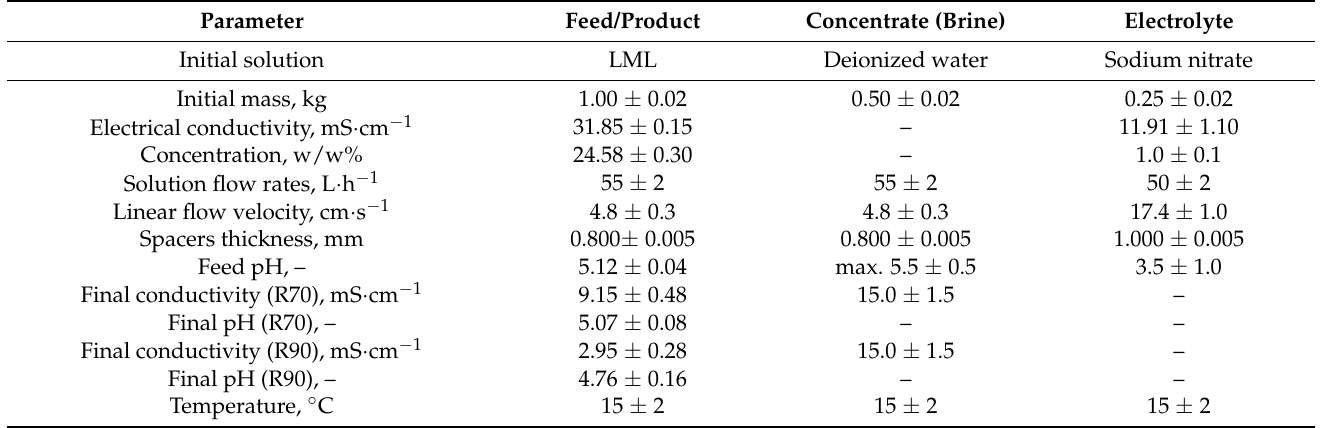
Figure 1. Scheme of the experiments. Lactose production ( a ) with evaporation and crystallization only ( b ) a combined ED process for LML recovery process and ( c ) dried LML product. Table 1. Key characteristics of the flows in the ED process.